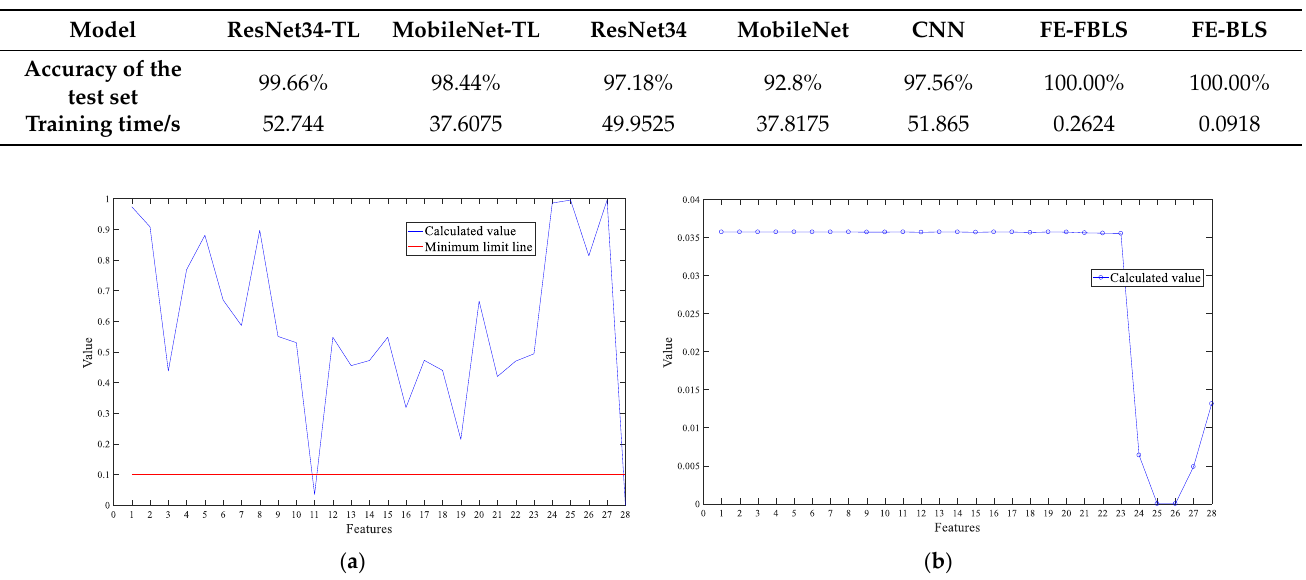
Table 3. Comparison of the accuracy of each classification model.